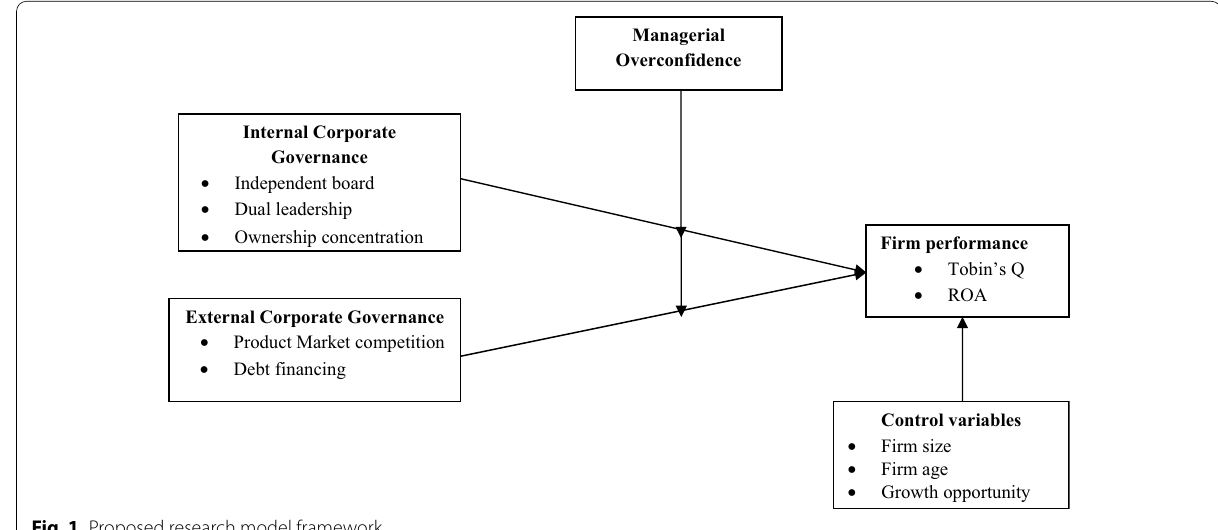
Fig. 1 Proposed research model